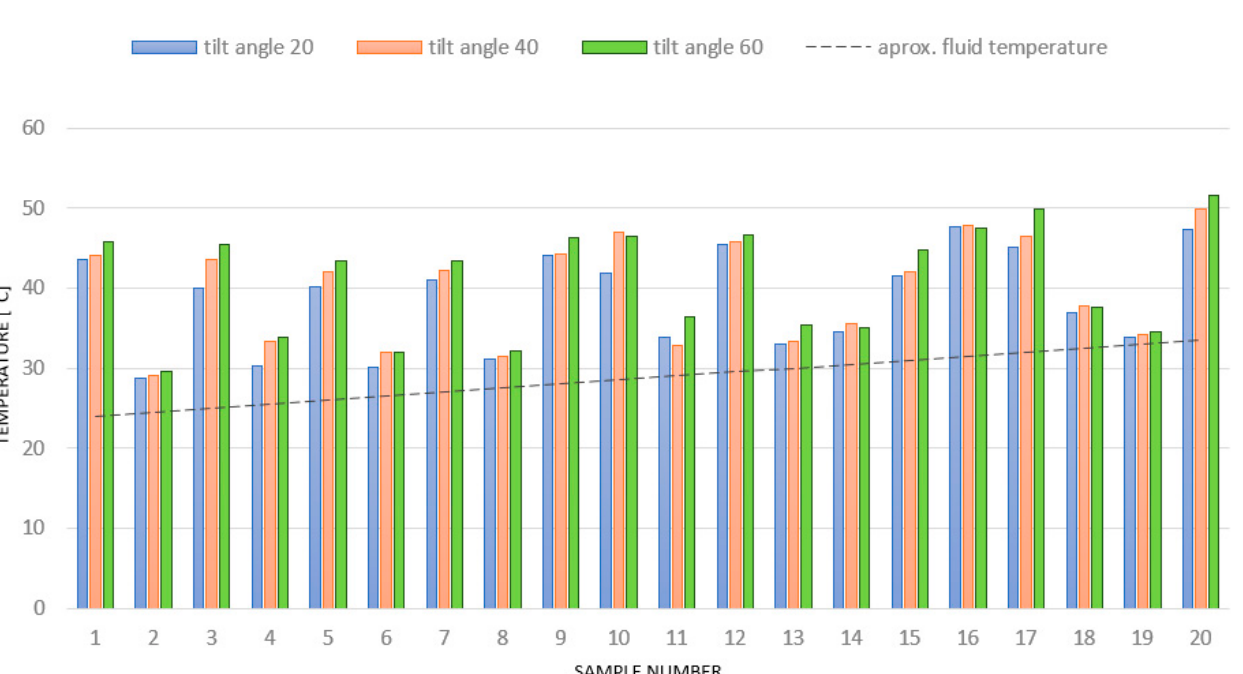
Figure 13. Thermograms taken during testing of the temperature distribution of the manifold. A series of measurements were performed for three different solar collector inclination angles β (20°, 40° and 60°). A series of thermograms were taken for each collector position, and then the temperature values were averaged for each evaporator socket. The results are shown in Figure 14.